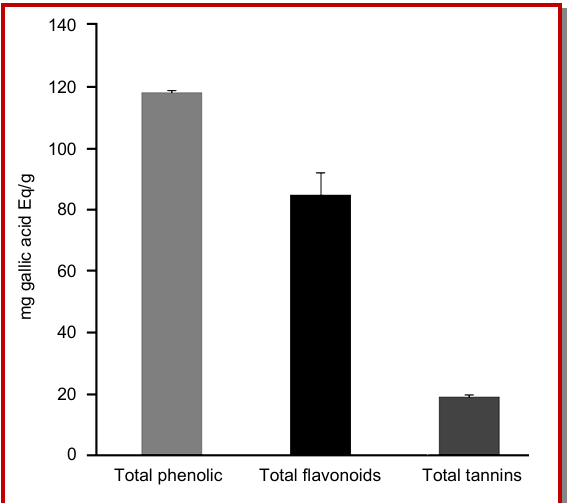
Figure 1: Total phenols, total flavonoids and condensed tannins in S. officinalis methanolic extract. The data represent the mean ± SD